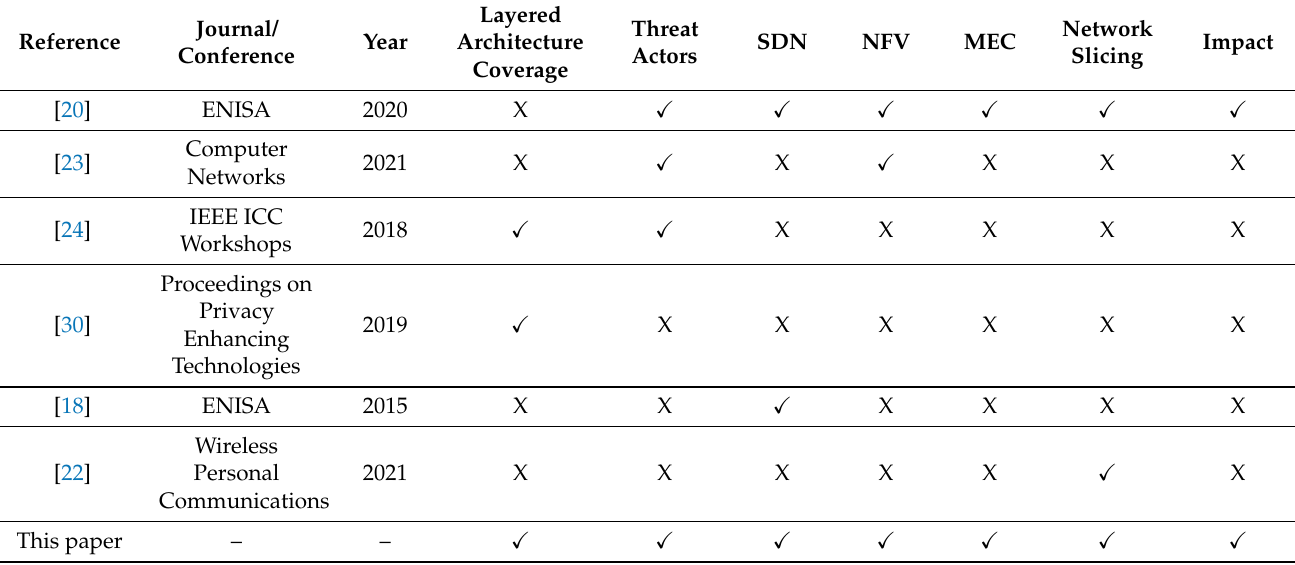
Table 1. Analysis of existing literature within 5G threat